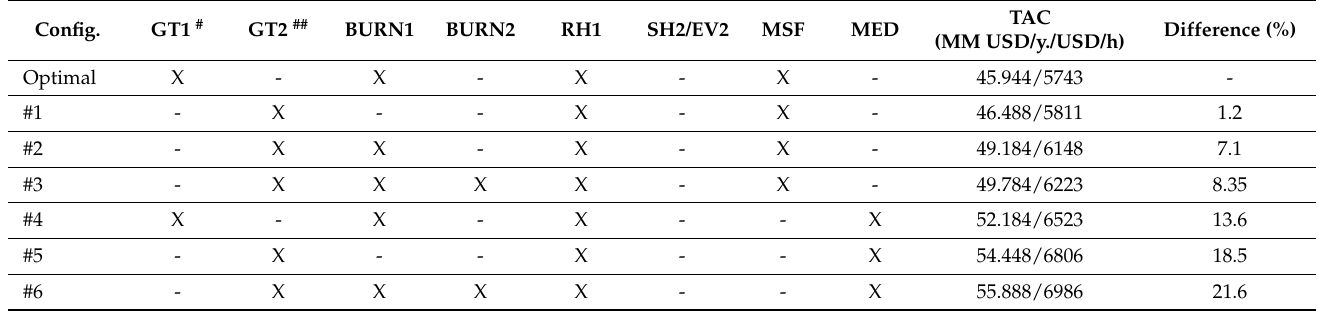
Table 3. Comparison of the costs obtained by the optimal and suboptimal configurations. Config.